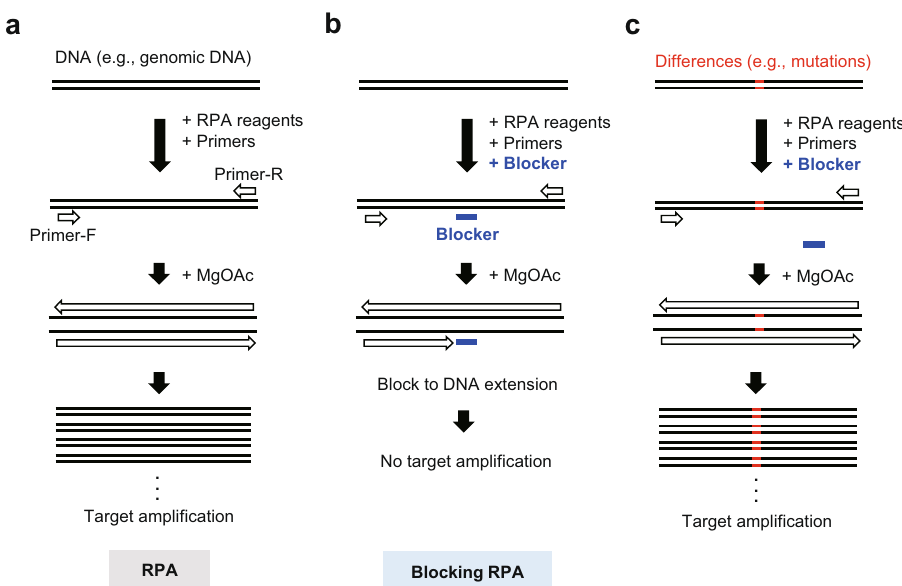
Fig. 1 Schematic diagram showing blocking RPA and its application. a During RPA, DNA polymerases extend DNA from primers, recruited to their complementary sequences by recombinases, in a magnesium acetate (MgOAc)-dependent manner. b In the presence of a sequence-speci fi c blocker (e.g., ORN), DNA extension by DNA polymerases is inhibited, resulting in the suppression of DNA ampli fi cation across the target sequence. c If the target sequence is mutated, it cannot be recognized by the blocking agent, and DNA ampli fi cation proceeds uninhibited (allowing for the detection of a DNA